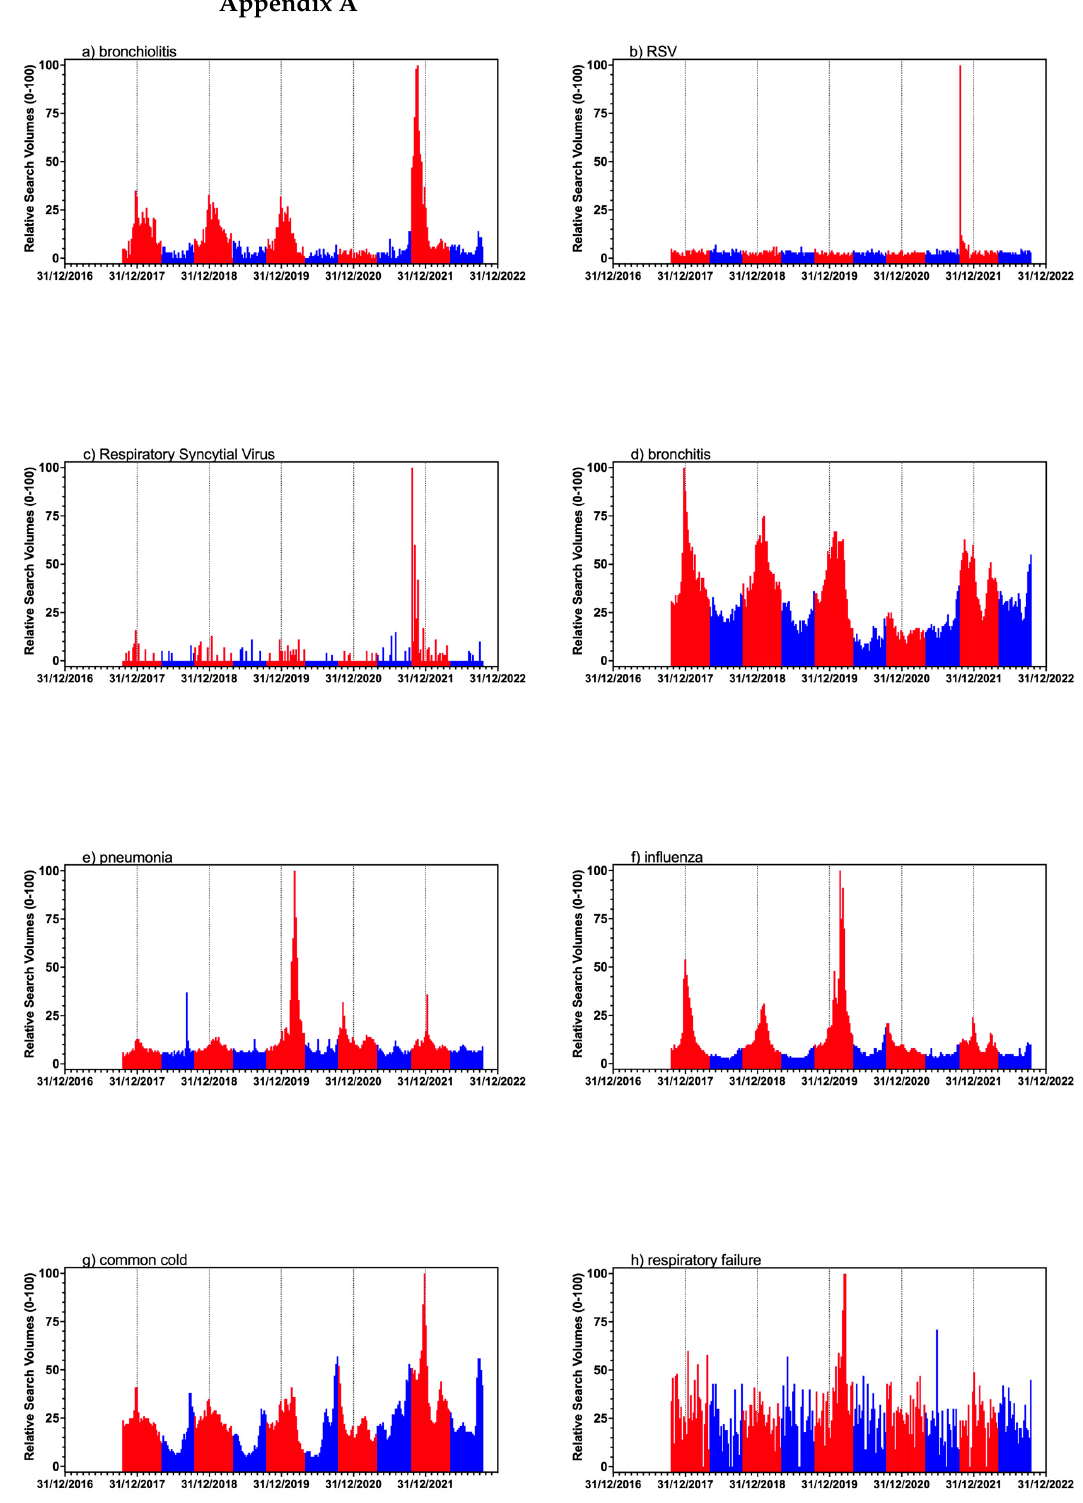
Figure A1. Seasonal trend of research terms for main clinical conditions associated with diagnoses of RSV included in the analyses: ( a ) bronchiolitis; ( b ) RSV, ( c ) Respiratory Syncytial Virus; ( d ) bronchitis; ( e ) pneumonia; ( f ) influenza; ( g ) common cold; ( h ) respiratory failure. Dotted lines represent 31 December of the correspondent calendar year. Red lines represent relative search volumes estimates for weeks included in the seasonal epidemiological surveillance for influenza-like illnesses, while blue lines represent weeks not included.